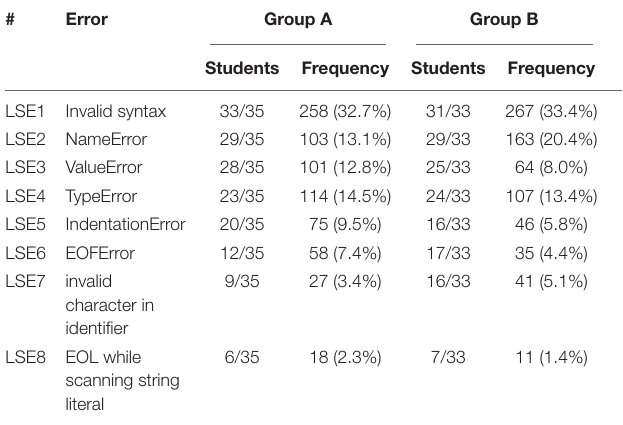
TABLE 3 | Comparison of two groups’ common